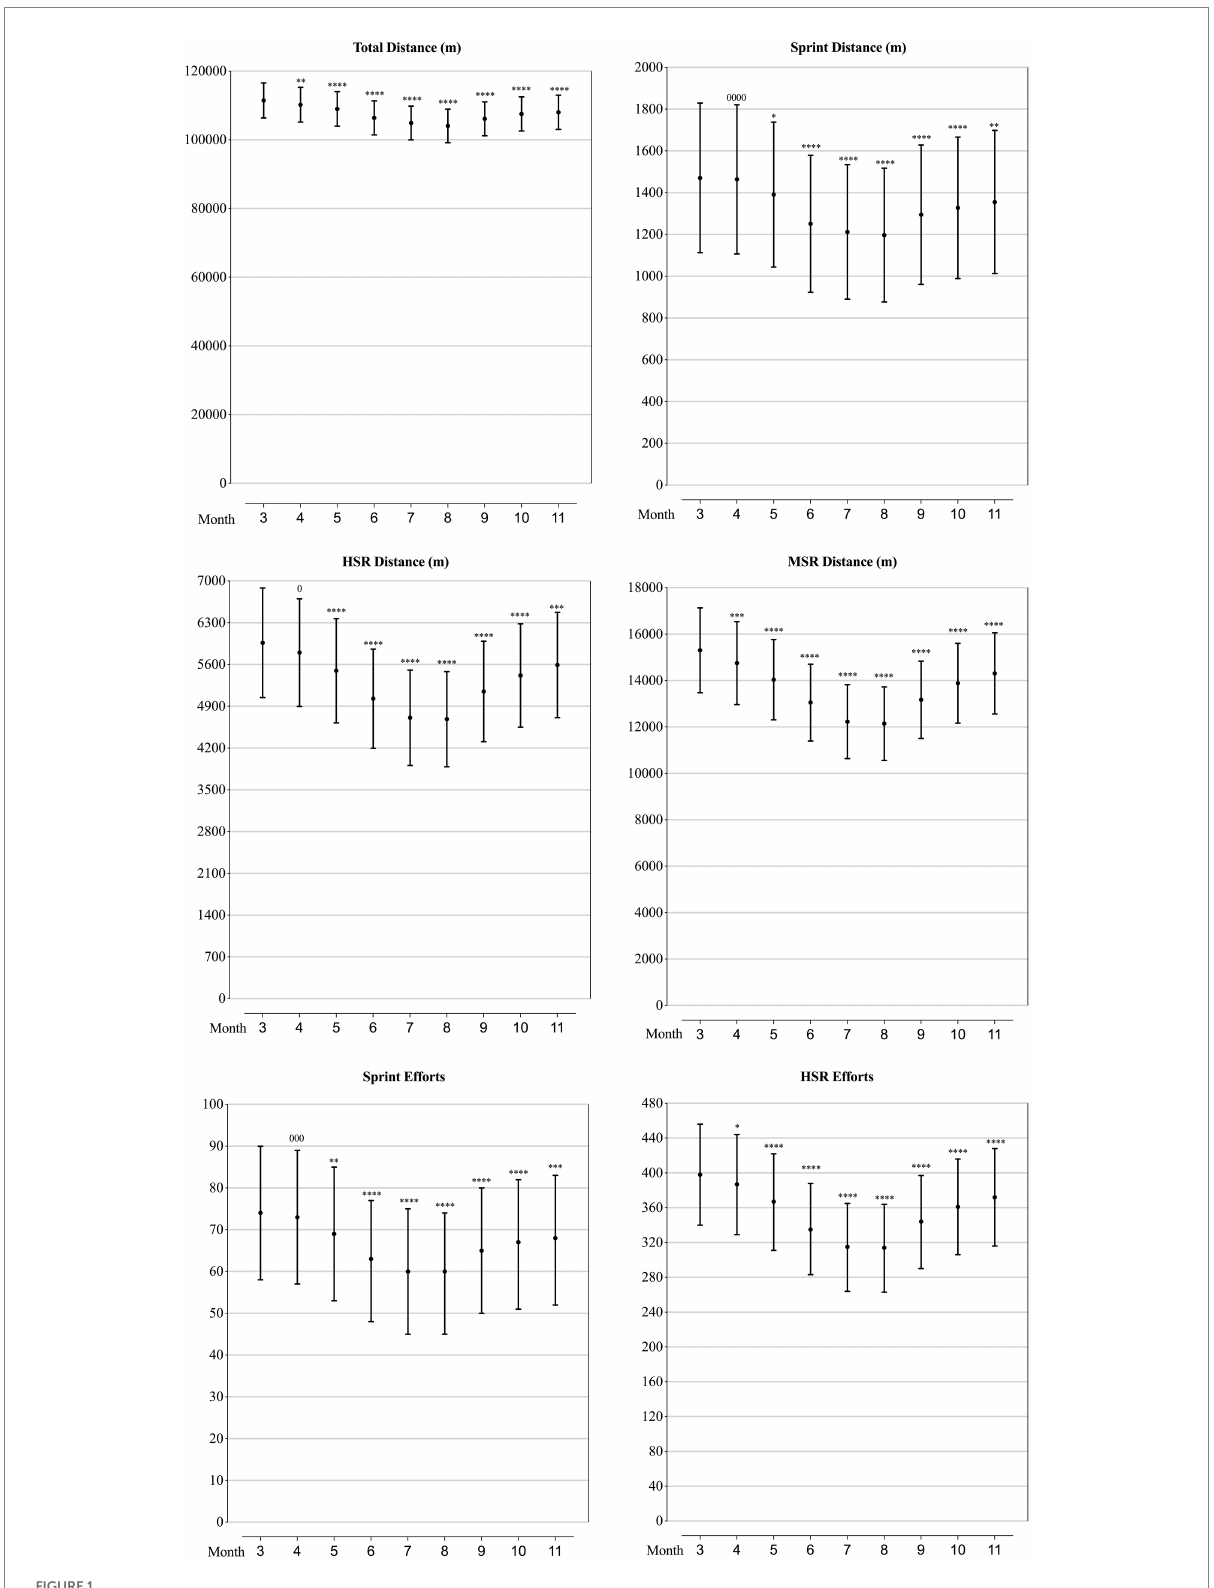
FIGURE 1 Values of physical performance-related parameters in each month of a season for the teams competing in the CSL in 2012-2019 estimated from the generalised mixed linear modelling. Filled dots are the means. Error bars are the standard deviations. Symbols “0” and “*” stands for trivial and negative change from the value of March (month “3”). Number of symbols indicate the likelihood for the magnitude of the true effect as follows: 1-possible; 2-likely; 3-very likely; 4-most